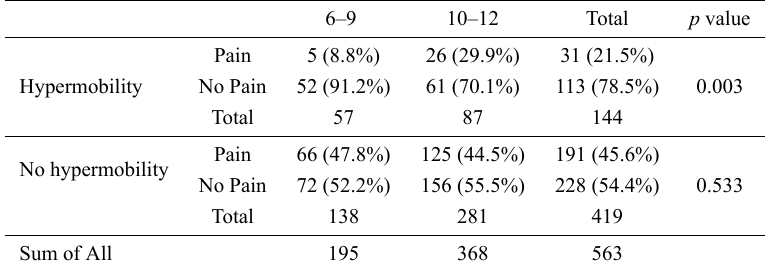
Table 6. Musculoskeletal pain and hypermobility including age